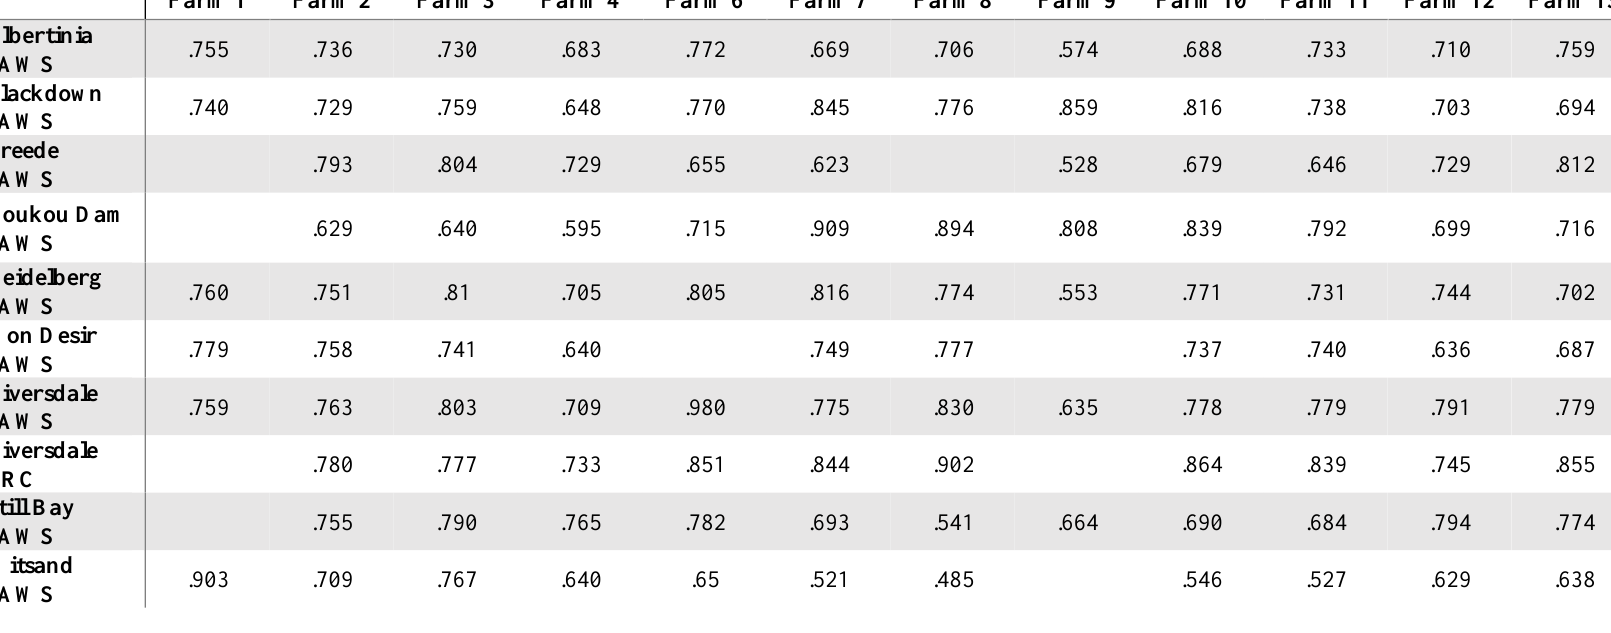
Table A3.3: Spearman’s rank correlation for rainfall recorded between farms and official weather stations (all correlation is significant at the 0.01 level